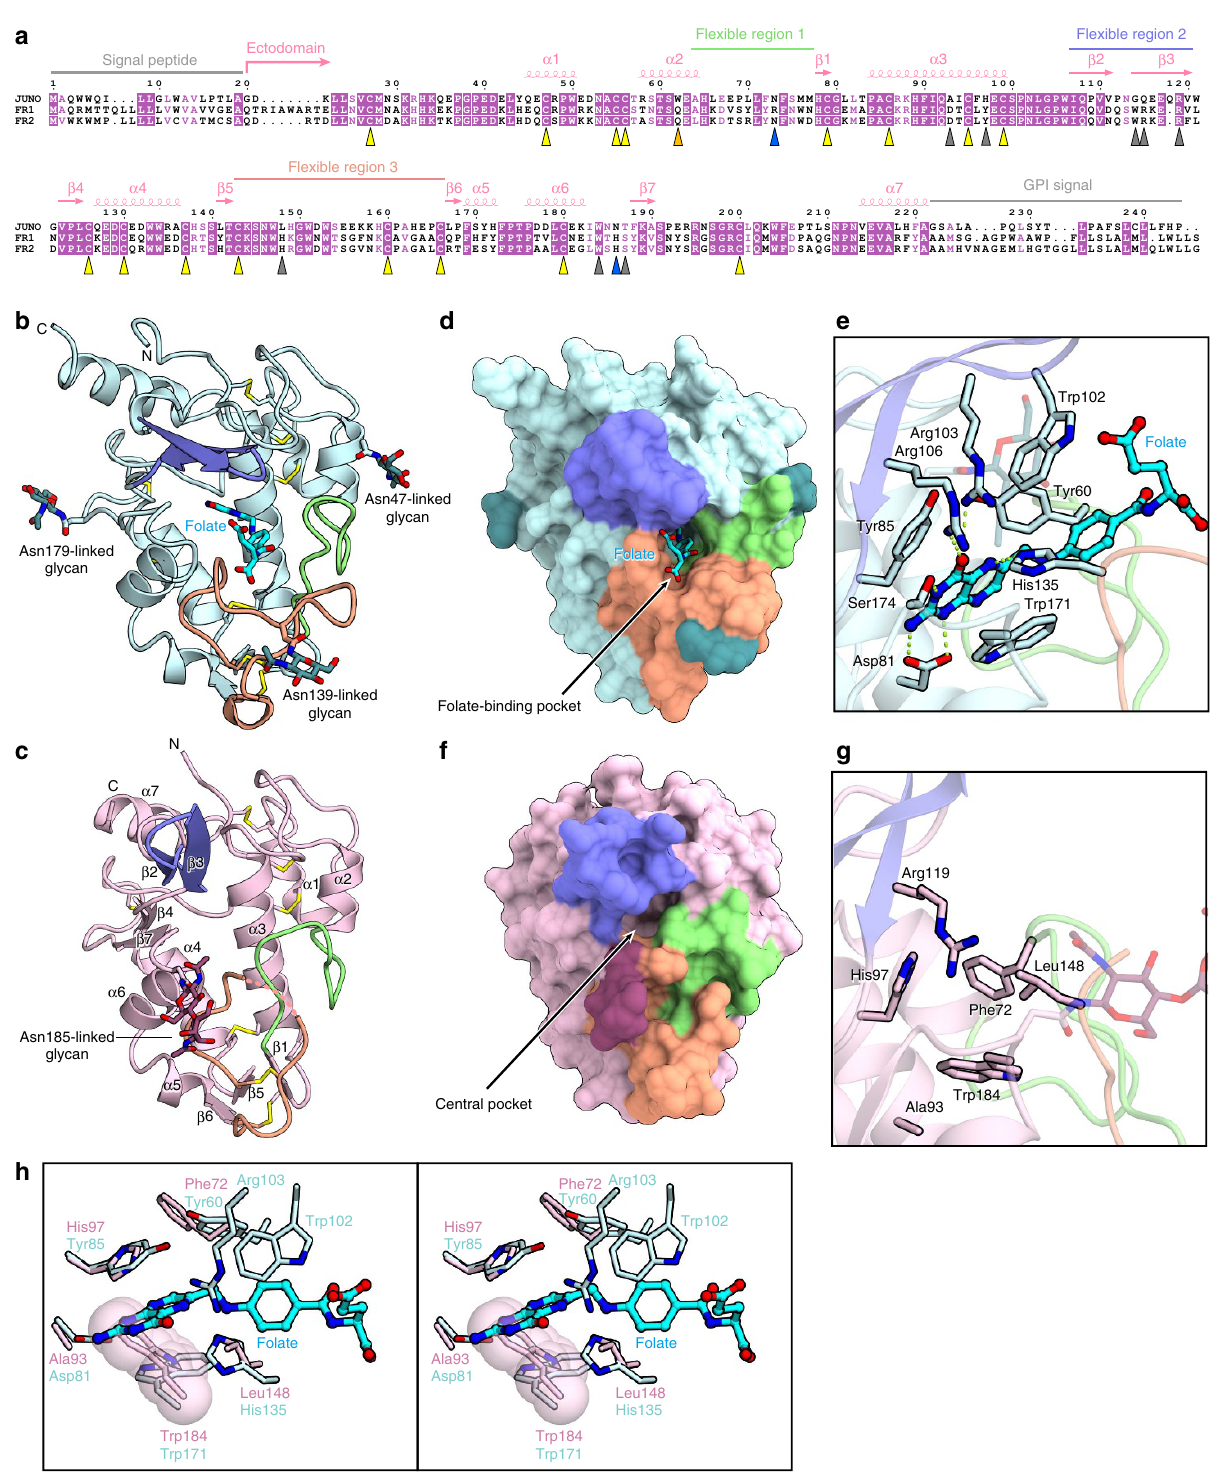
Figure 2 | Comparison of JUNO with the FRs. ( a ) Multiple sequence alignment of mouse JUNO, human FR1 and human FR2. The FR1 residues involved in folate binding are indicated by grey triangles. The other key residues are indicated as in Fig. 1a. ( b , c ) Ribbon representation of the human FR1–folate complex (PDB code 4LRH) ( b ) and N73D mutant JUNO ( c ). ( d , e ) Molecular surface ( d ) and folate-binding pocket ( e ) of the human FR1–folate complex (PDB code 4LRH). ( f , g ) Molecular surface ( f ) and central pocket ( g ) of N73D mutant JUNO. ( h ) Superimposition of the central pocket of N73D mutant JUNO and the folate-binding pocket of FR1 (stereo view). Trp184 of JUNO is highlighted as a semi-transparent space-filling and 20mM imidazole). The bound protein was eluted with the wash buffer sup- instructions, and baculovirus-infected Sf9 cells were cultured in Sf900II medium plemented with 500mM imidazole, and then dialysed against the wash buffer to (Invitrogen) at 27 (cid:2) C for 48h before collecting. The culture supernatant was remove the imidazole. The protein was incubated with Talon cobalt affinity resin incubated with Ni Sepharose excel resin (GE Healthcare) at 4 (cid:2) C overnight, and the (Clontech). The resin was washed with the wash buffer, and then the protein was resin was then washed with wash buffer (20mM Tris-HCl, pH 7.5, 150mM NaCl